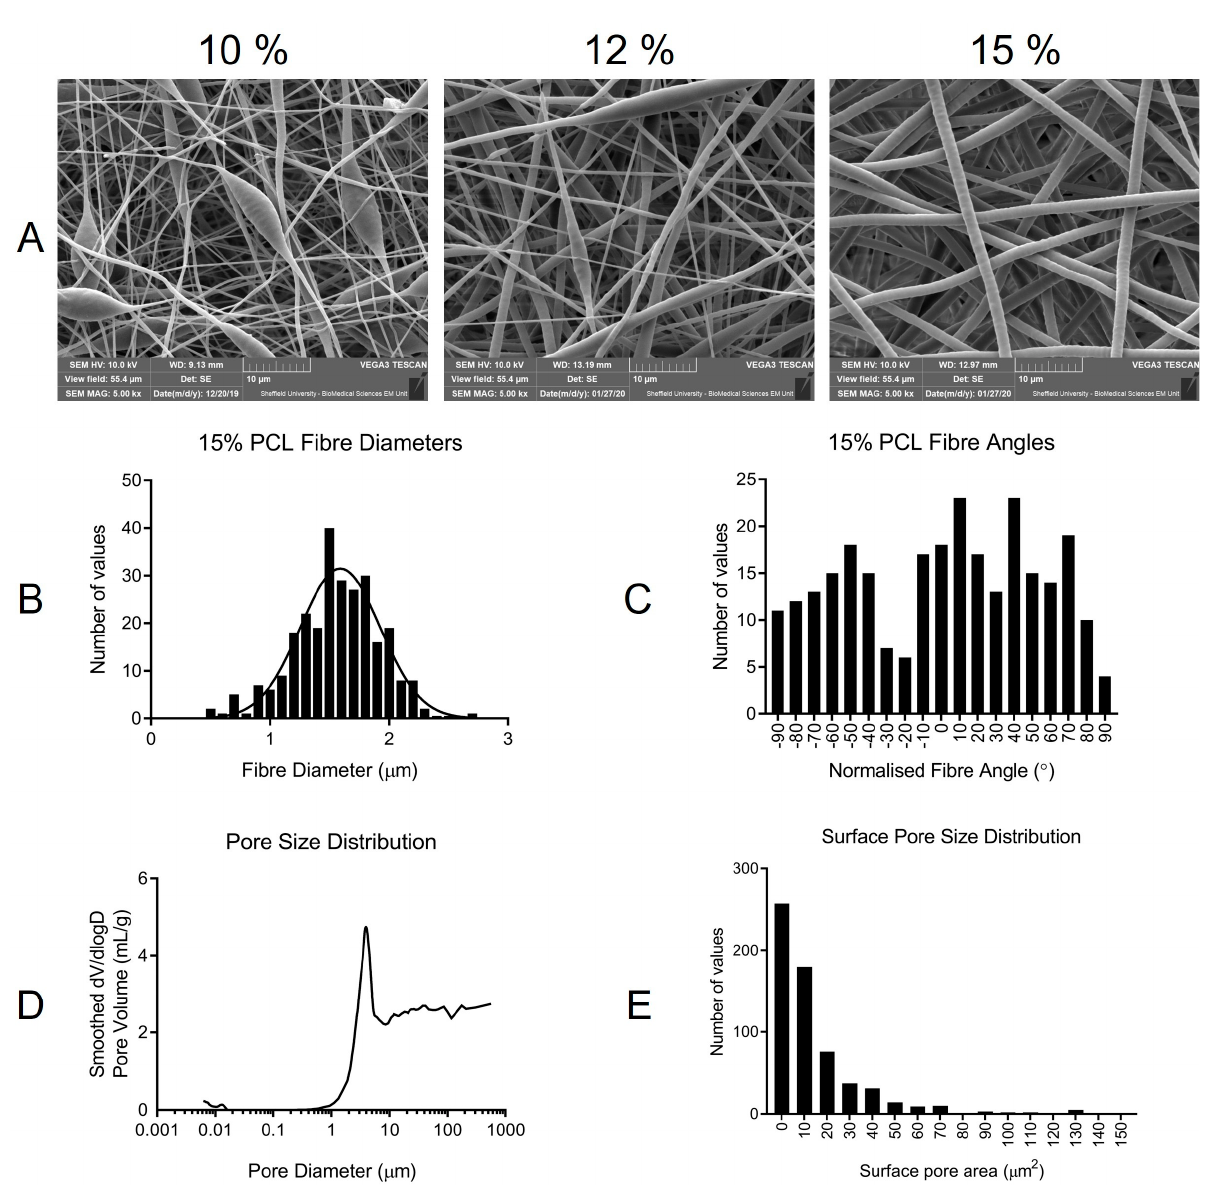
Figure 1. ( A ) Representative SEM images of 10, 12, and 15% ( w/v ) PCL electrospun scaffolds. Beading is evident at 10% and fibres vary in diameter at 12% before homogenizing at 15%. Further characterisation was only completed with 15% ( w/v ) scaffolds. ( B ) Fibre diameters are normally distributed according to the D’Agostino and Pearson normality test, and a Gaussian non-linear regression was plotted. ( C ) Fibre angle distribution. For angle and diameter, 10 fibres were measured in each of 27 images taken from 9 samples and isolated from 3 scaffolds (biological replicates = 3, technical replicates = 3). ( D ) Mercury Intrusion Porosimetry. Pore diameter distribution was plotted from intrusion data using GraphPad Prism. Only one sample was used for intrusion data ( E ) Surface pore area distribution (biological replicates = 3, technical replicates = 3).